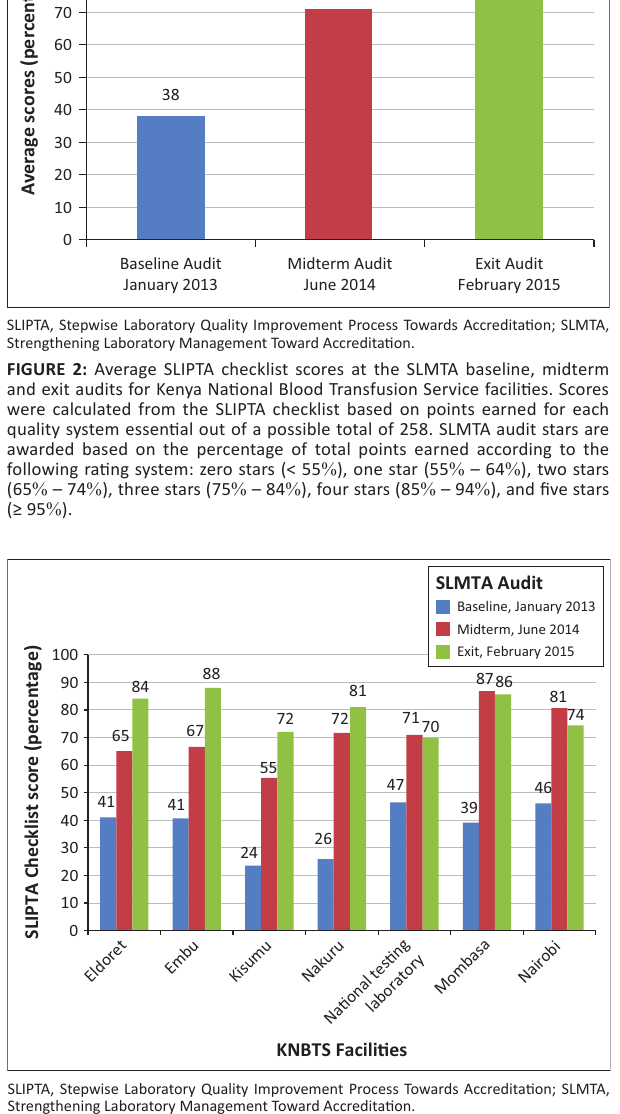
FIGURE 3: Progress of Kenya National Blood Transfusion Service facilities in the SLMTA process. For each SLMTA audit, scores were calculated from the SLIPTA checklist based on points earned for each quality system essential out of a possible total of 258.